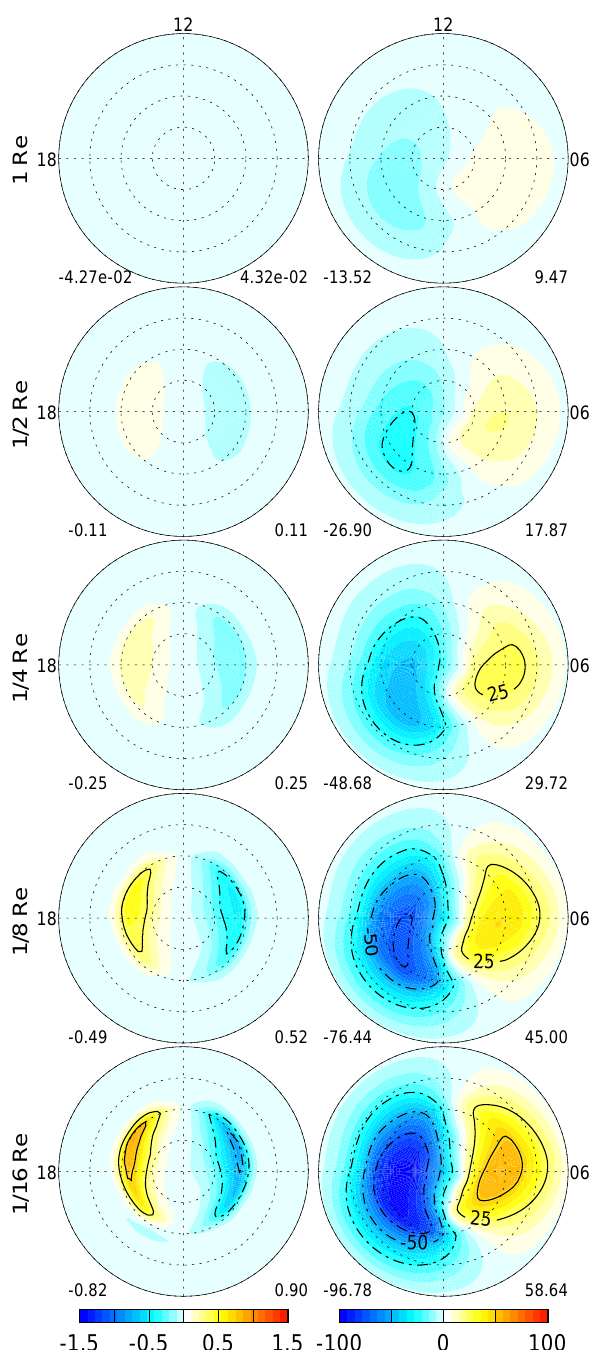
Fig. 2. The ionospheric field-aligned currents (left, in µA/m 2 ) and potentials (right, in kV) in an MLT-magnetic latitude coordinate system, with noon at the top and dawn on the right. The outer ring is 50 ◦ latitude. The maximum and minimum values for each plot are indicated. The rows correspond to the various grid resolutions from 1 R E (top) to 1/16 R E (bottom).